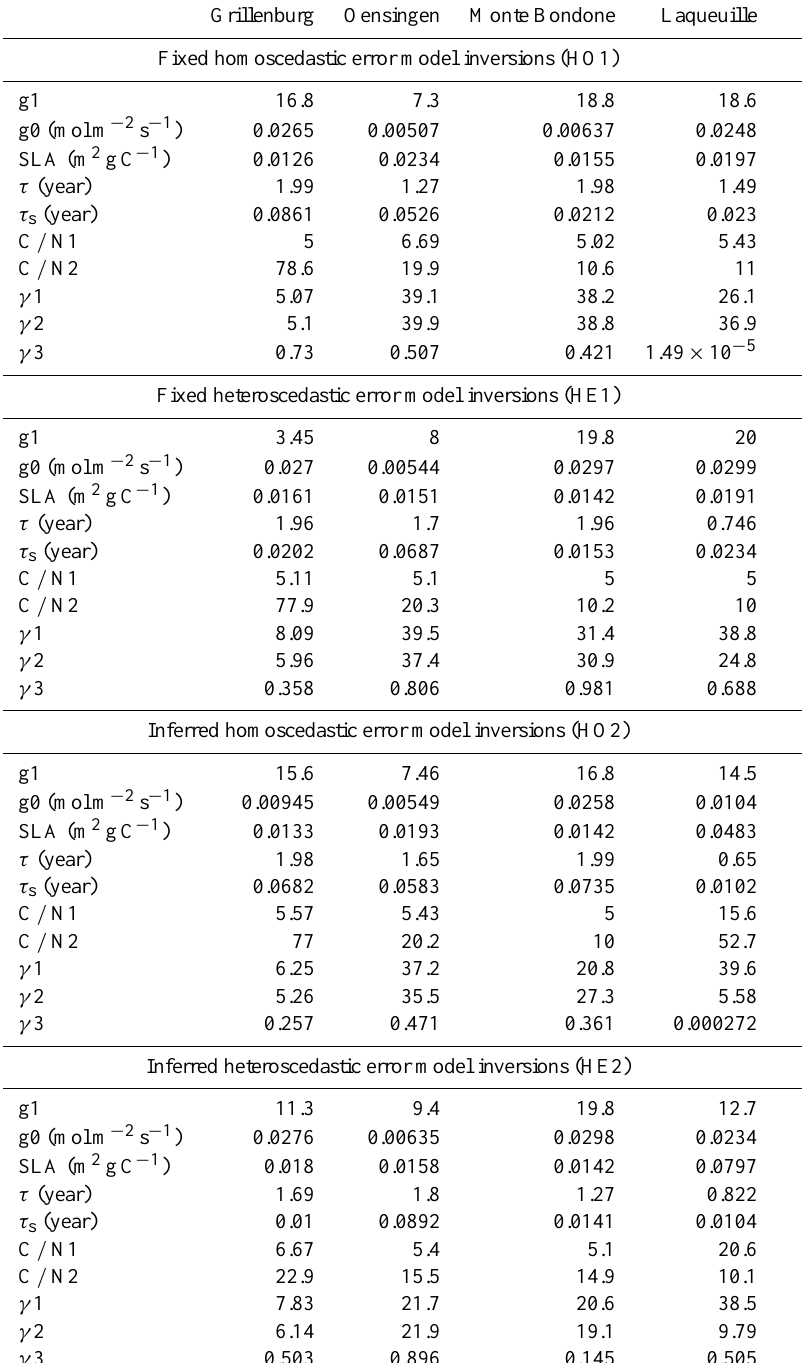
Table 3. Most likely CARAIB model parameter values for all inversion